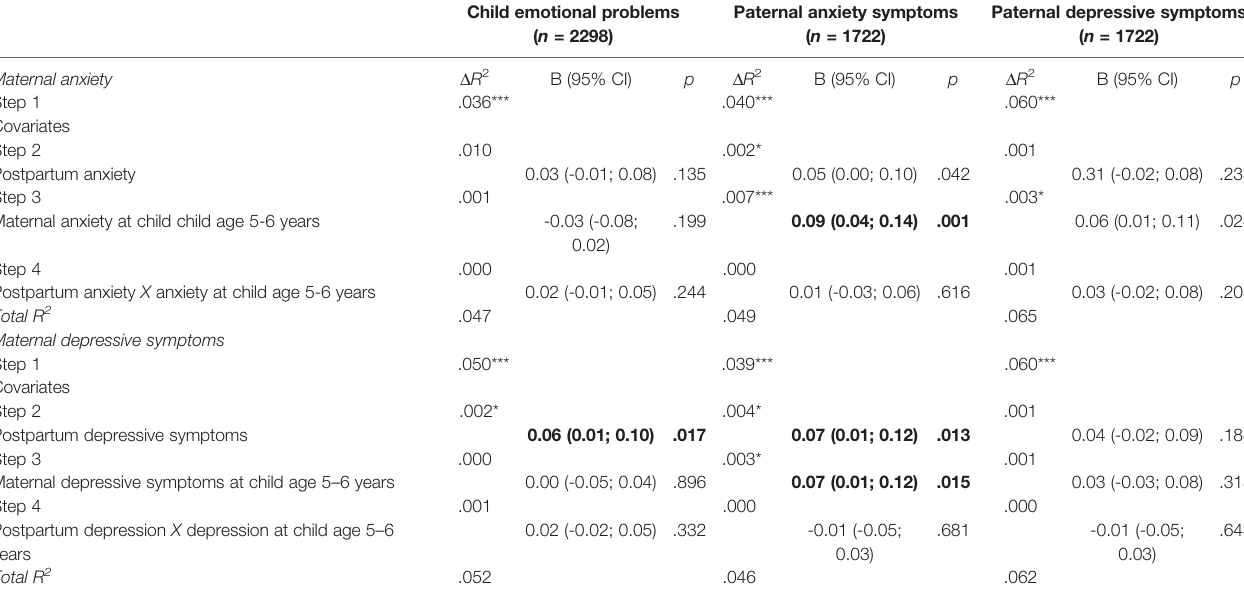
Child emotional problems Paternal anxiety symptoms Paternal depressive symptoms ( n = 2298) ( n = 1722) ( n = 1722)